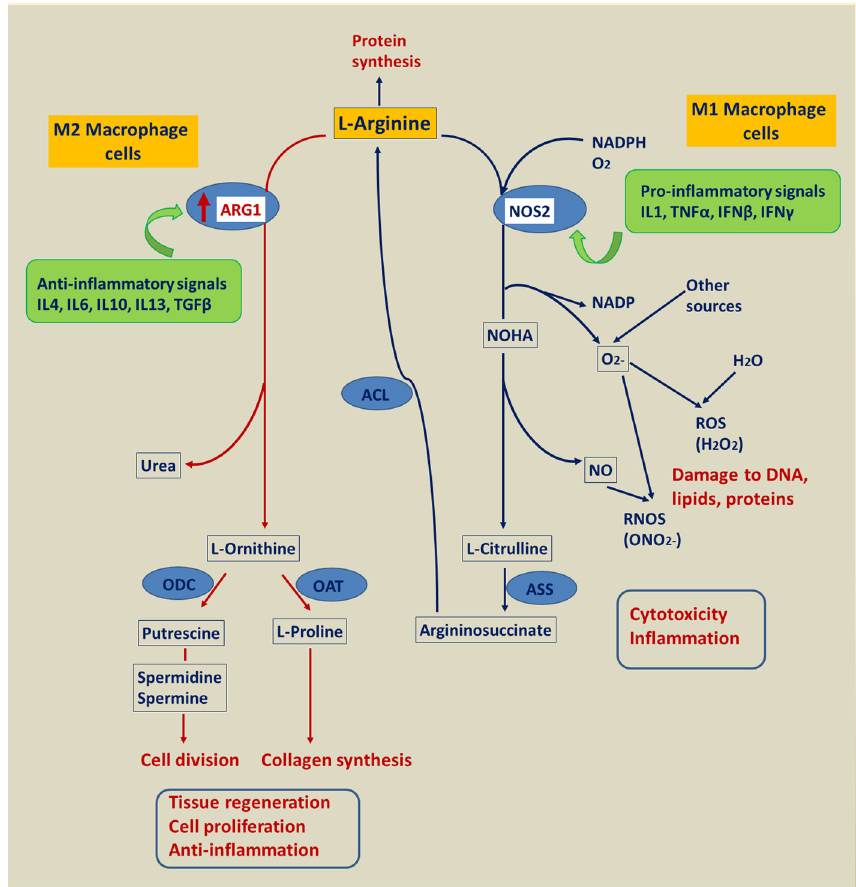
Fig 4. Model of reciprocal regulation of arginase 1 (ARG1) and nitric oxide synthase 2 (NOS2). Downstream metabolic products (blue framed) and their association with components of inflammatory responses (red). Enzymes (blue ellipses), NOHA: N-hydroxyarginine, OAT: ornithine aminotransferase, ODC: ornithine decarboxylase, ACL: argininosuccinate lyase, ASS: argininosuccinate synthetase. ROS: reactive oxygen species, RNOS: reactive nitrogen oxide species. Red arrows indicate consequences of ARG1 upregulation in AC cows vaccinated after